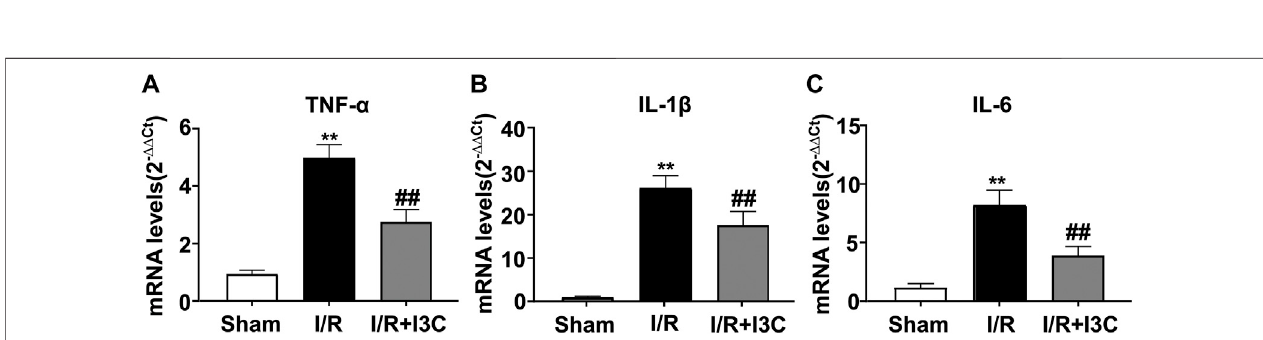
FIGURE 4 | Effect of I3C on antioxidant stress parameters in myocardial tissue of I/R mice. (A,B) Quantitative analysis showed that the I3C pretreatment (100 mg/kg) prevented I/R-induced decrease in T-AOC (A) and GSH (B) levels inischemic cardiac tissue ( n =5,** p < 0.01 vs. shamtreatment, ## p < 0.01vs. I/R). Data are expressed as mean ± SEM.